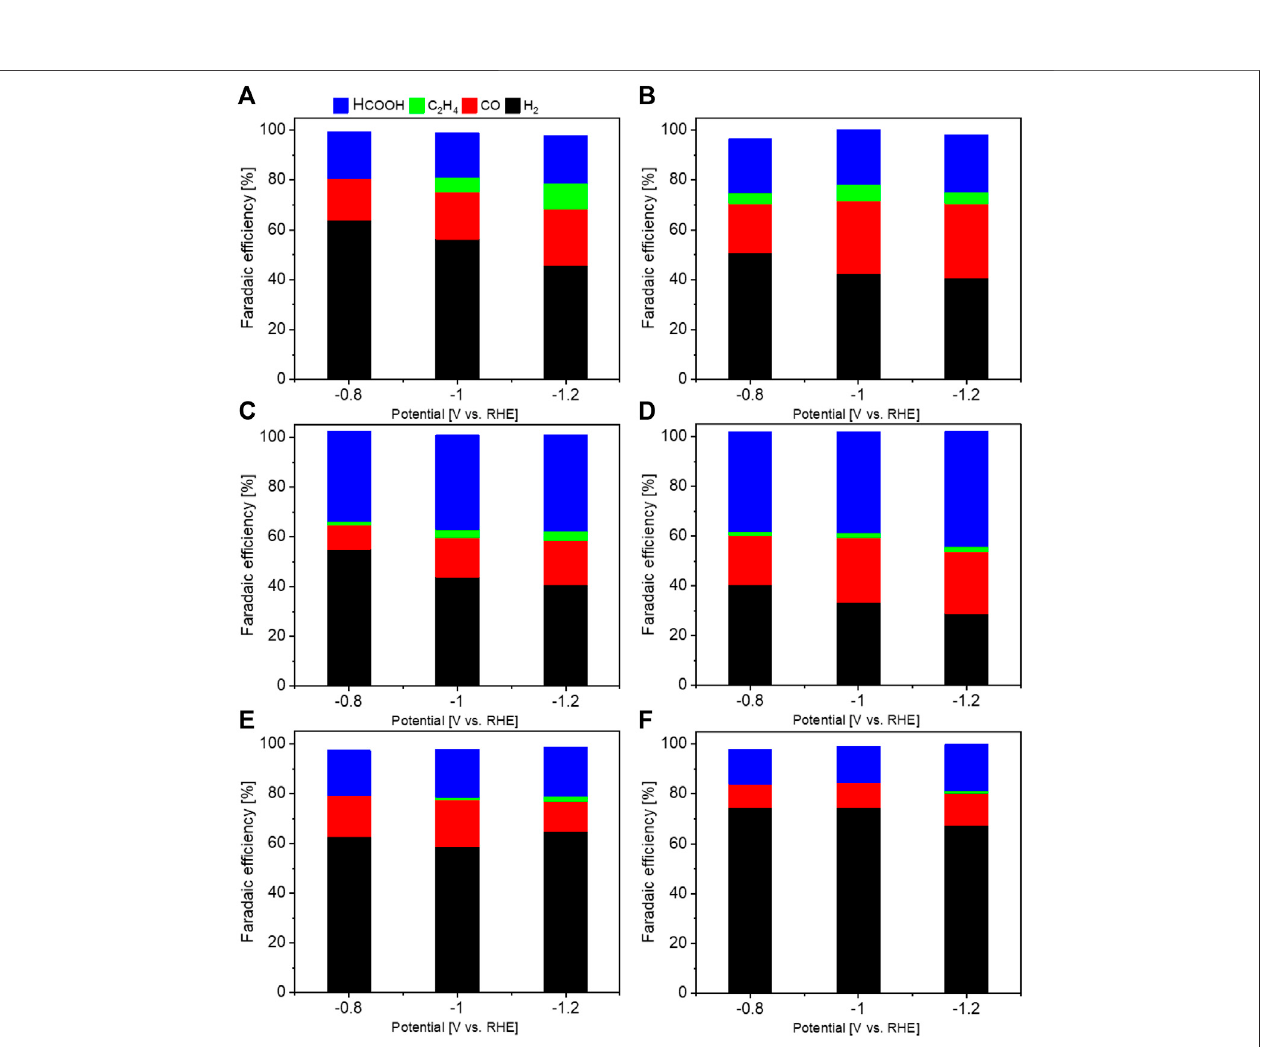
Frontiers in Chemistry | www.frontiersin.org July 2022 | Volume 10 | Article 931767